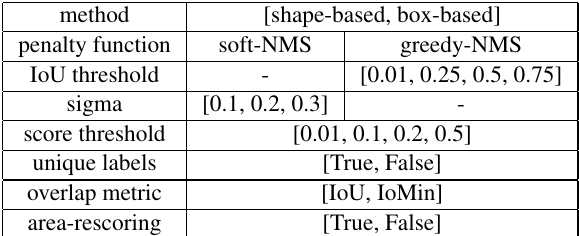
Table 1. Evaluation parameter grid.